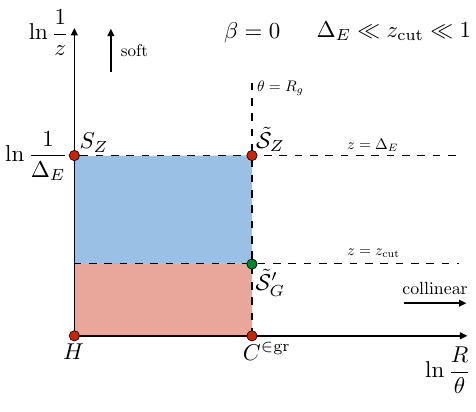
Figure 13 . The Lund diagram for the jet energy drop with soft drop grooming and β = 0